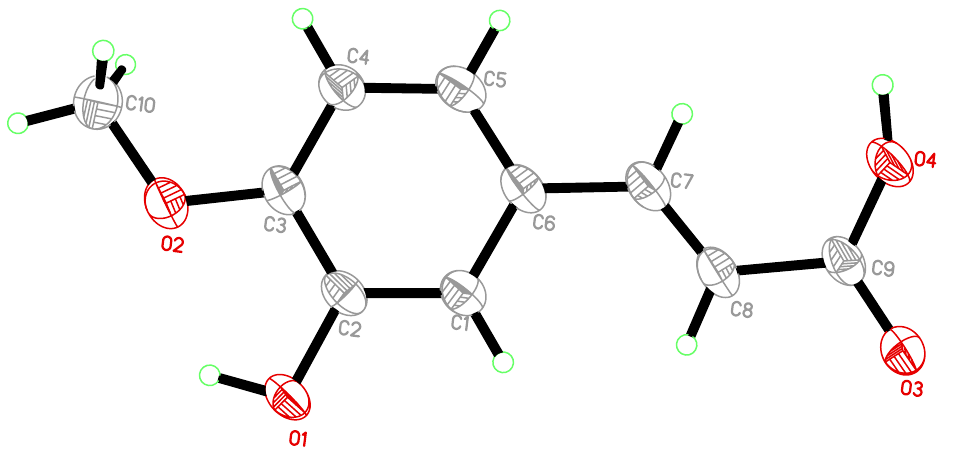
Figure 2. Single-Crystal X-ray ORTEP. diagram of trans -isoferulic acid ( 4